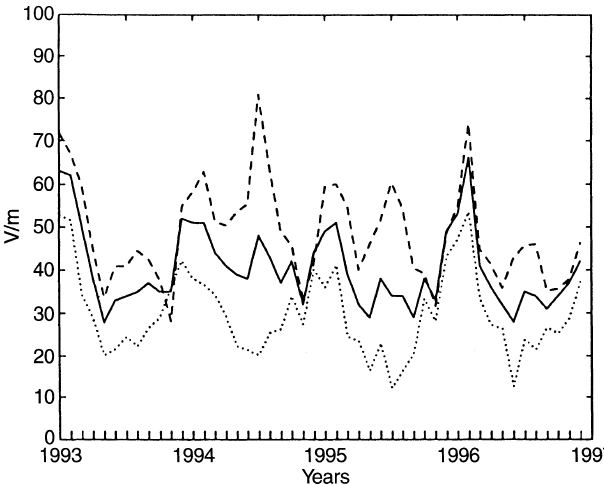
Fig. 3. Monthly means of the PG (in V/m) based on di(cid:128)erent data sets for the same interval as in Fig. 2; middle : all hours (00–24 UT); top : day-time hours (10–16 UT); bottom : night-time hours: